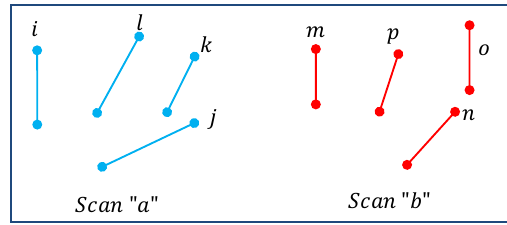
Figure 3. Simulated scenario of lines with the same separation values